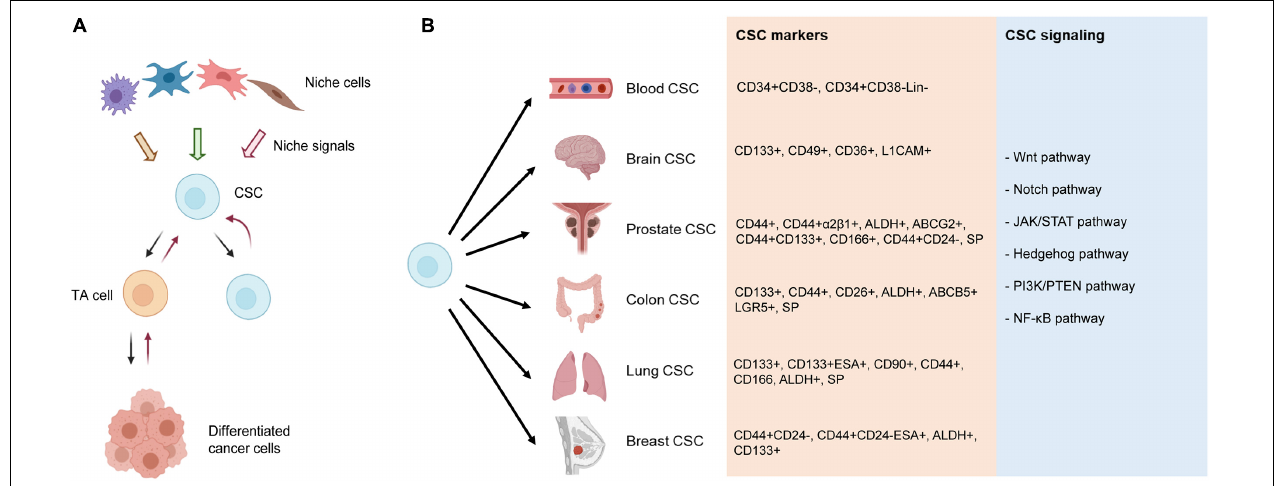
FIGURE 3 | Current understanding of CSCs and CSC markers in representative tumors. (A) CSC “hierarchy.” In early-stage treatment-naive tumors, the CSC, residing in the CSC niche consisting of many different niche cells, undergoes asymmetric cell division (ACD) generating one CSC and one transient amplifying (TA) cell, with the latter dividing rapidly and developing into phenotypically “differentiated” cancer cells (indicated by forward black arrows) that may well represent the bulk of the tumor. Upon therapeutic interventions and/or (epi)genetic mutations (not shown), the TA cell and even fully differentiated cancer cells can be reprogrammed (i.e., dedifferentiate) into CSCs, a property often called plasticity. (B) Reported CSC markers in the representative cancers. Shown on the right are several major developmental and signaling pathways commonly deregulated in CSCs and various cancer types. SP, side